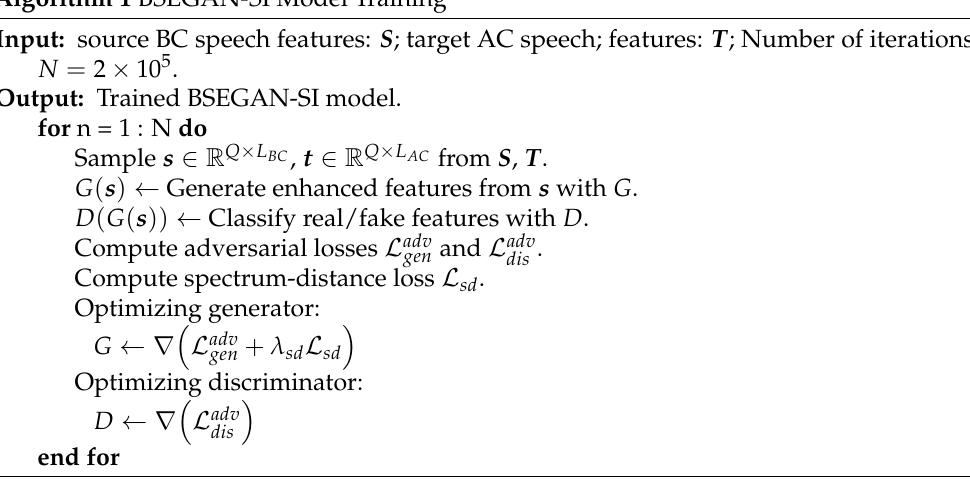
Algorithm 1—the overall optimization process of the proposed BSEGAN-SI model in the training process is described in detail. Algorithm 1 BSEGAN-SI Model